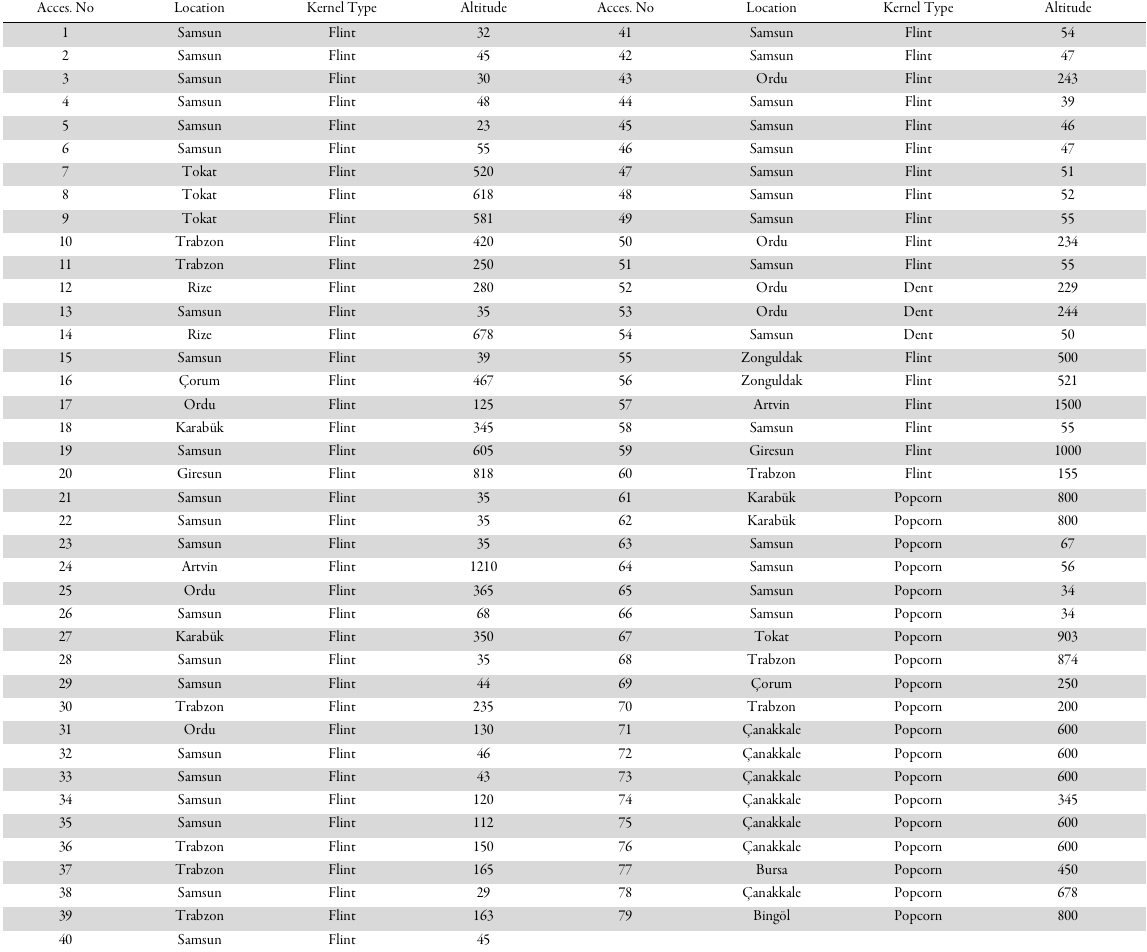
Table 1. Accession number, location of accessions, kernel type, and altitude of maize accessions Acces.